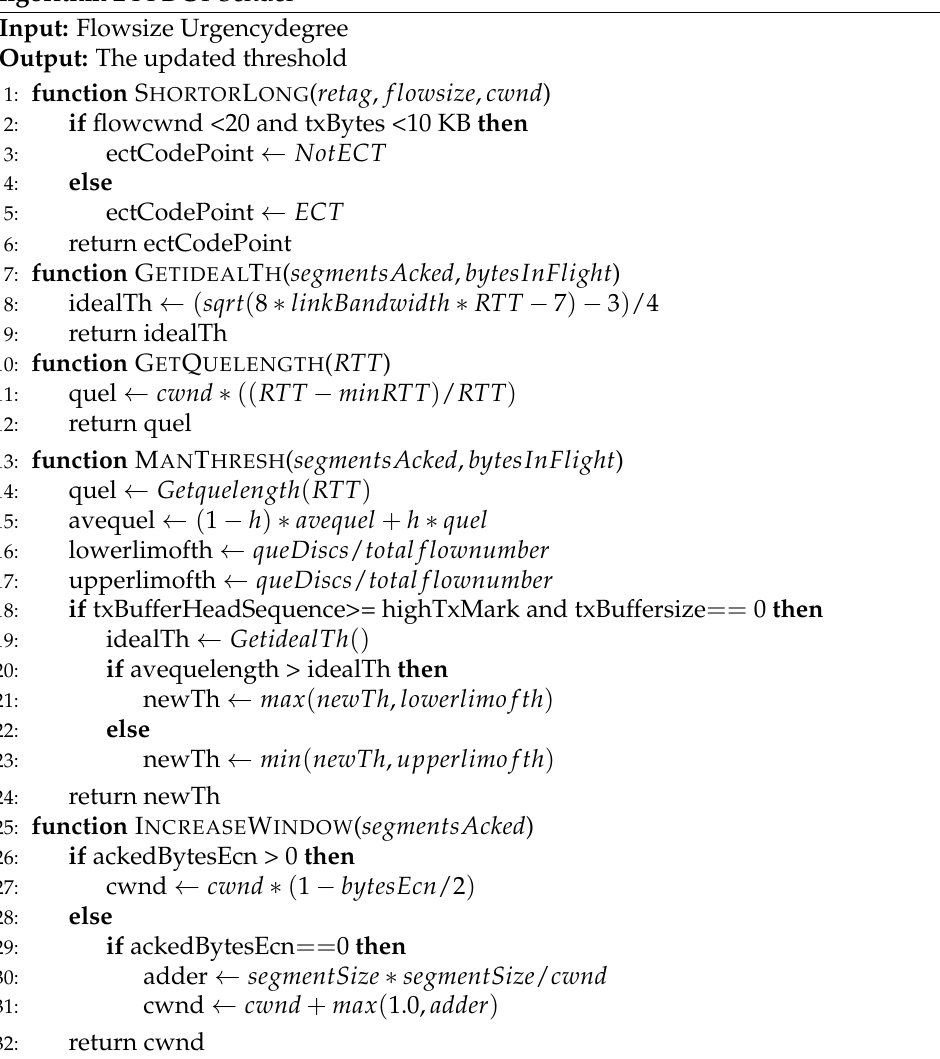
Algorithm 2 PFDCT